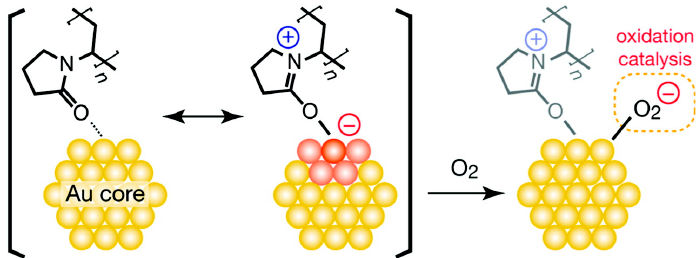
Figure 4. Dioxygen activation by PVP ‐ induced charge transfer. Reproduced with permission from ref. ref. [57]. Copyright2009, American Chemical